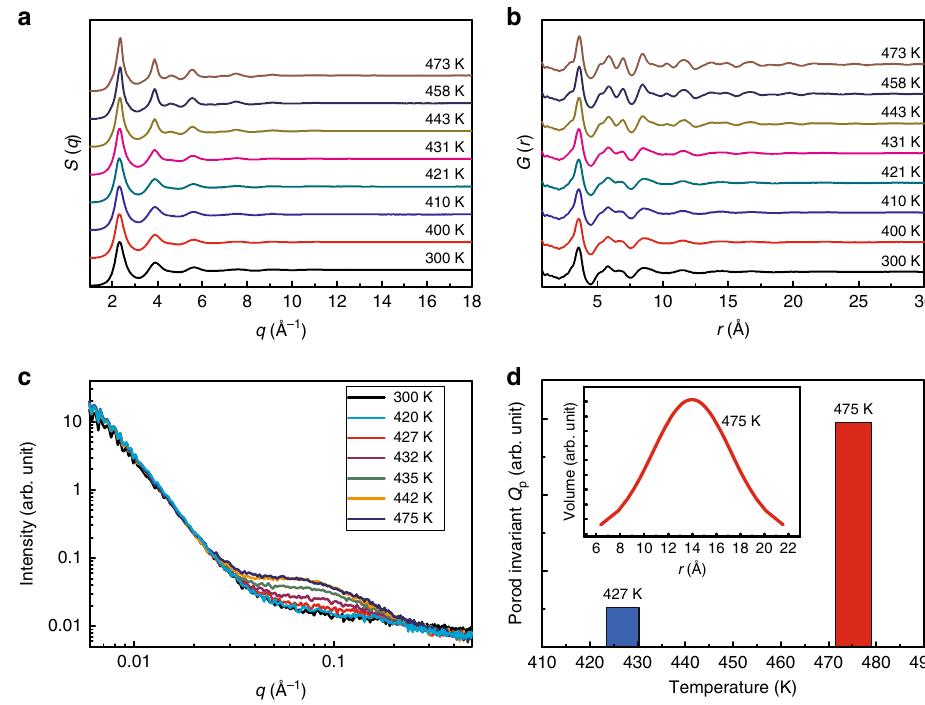
Fig. 2 The structural evolution of the as-prepared Ce 65 Al 10 Co 25 MG at high temperatures. a S ( q ) and b G ( r ) at representative temperatures. More features emerged in the patterns indicate that more ordered states were obtained during heating, but no sharp Bragg diffraction peaks were observed. c Representative SAXS data in the ordering temperature range, data at 300 K are also shown for comparison. The initial sample at 300 K is homogeneous according to its monotonically decayed data, whereas a hump at ~ 0.08 Å is observed when ordering starts above 427 K, implying density fl uctuation emerges. d The comparison of Porod invariant at 427 K and 475 K relative to the value at room temperature, implying a considerable increasing of the volume of the heterogeneous scatterers upon heating from 427 K to 475 K. The size distributions of the scatterers at 475 K is shown in the inset, indicating an average radius limited to ~ 14 Å at this